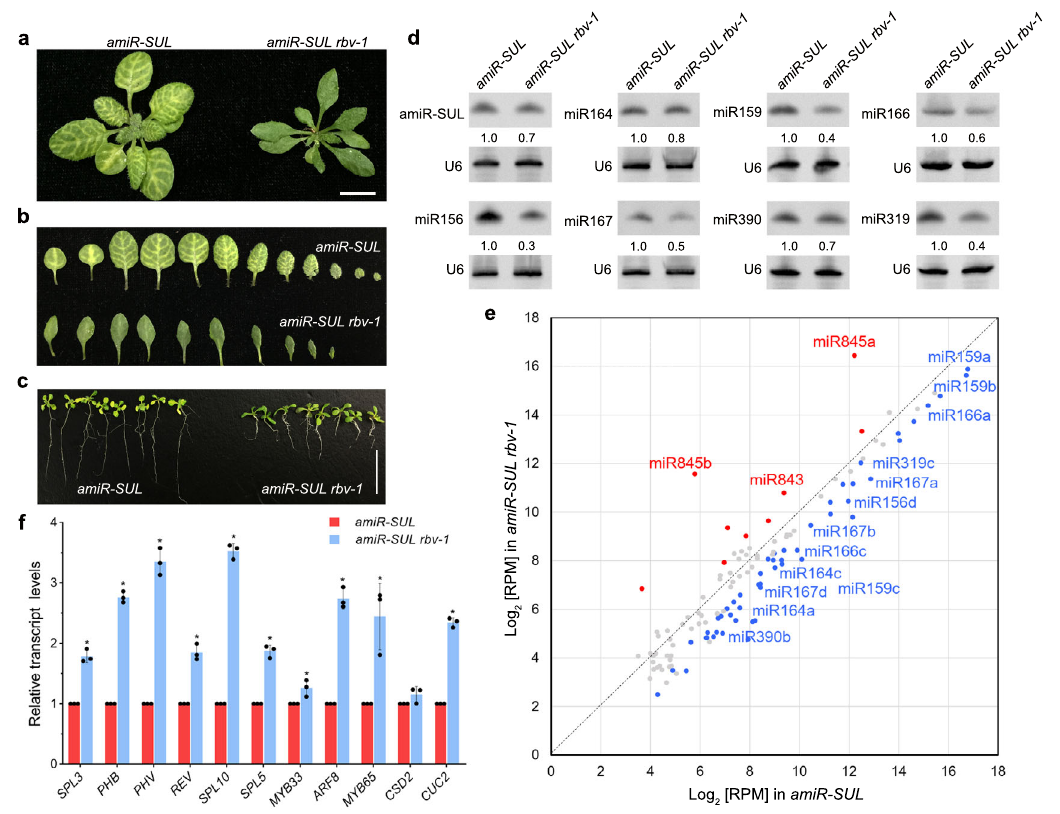
Fig. 1 Isolation of the silencing suppressor mutant rbv-1 from an amiR-SUL line. a Phenotypes of 1-month-old amiR-SUL rbv-1 and amiR-SUL plants. Bar = 1 cm. b Images of rosette leaves from 1-month-old plants grown under long-day conditions. c 14-day-old seedlings showing reduced root length in amiR-SUL rbv-1 . Bar = 1 cm. d RNA gel analysis showing reduced accumulation of amiR-SUL and endogenous miRNAs in the amiR-SUL rbv-1 mutant. U6 was used as an internal control. The numbers represent relative abundance. Two independent repeats gave similar results. e A scatter plot showing the abundance of miRNAs in amiR-SUL rbv-1 and amiR-SUL as determined by small RNA-seq with 14-day-old seedlings. miRNA abundance was calculated as reads per million mapped reads (RPM) and miRNAs with RPM > 10 in either genotype are shown. The red dots indicate miRNAs with higher levels in amiR- SUL rbv-1 , and the blue dots indicate miRNAs with lower levels in amiR-SUL rbv-1 . (Student ’ s t test, * P < 0.05). f Determination of miRNA target mRNA levels in amiR-SUL and amiR-SUL rbv-1 in 14-day-old seedlings by RT-qPCR. UBQUITIN5 ( UBQ5 ) was used as the internal control. The values were relative to those in amiR-SUL . Error bars represent standard deviation from three technical replicates. Asterisks indicate a signi fi cant difference between amiR-SUL and amiR-SUL rbv-1 (Student ’ s t test, * P < 0.05). Source data are provided as a Source Data fi